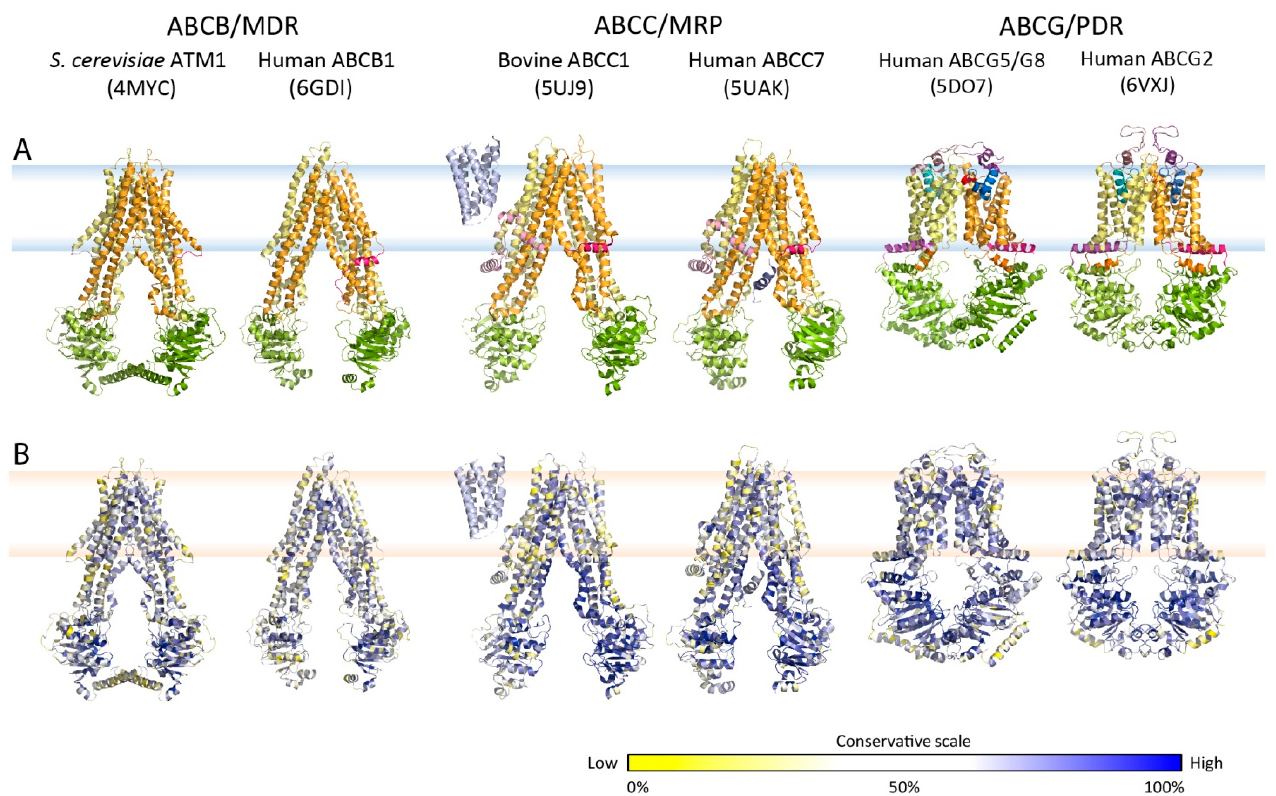
Figure 2. Atomic structures, folds and evolutionary conservation of MDR exporters. ( A ) Crystal or cryo-EM particle structures of multidrug resistance-related ABC exporters from the type I (ABCB and ABCC) and type II families (ABCG subfamily) using the color codes as shown in Figure 1B. ( B ) Conservation analysis of ABC exporters from panel A. Multiple sequence alignments of amino acid sequences from Tables 1 and 2 were generated for all subfamilies. The degree of conservation was calculated and indicated as a color gradient ranging from low conservation (yellow) to high conservation (blue).